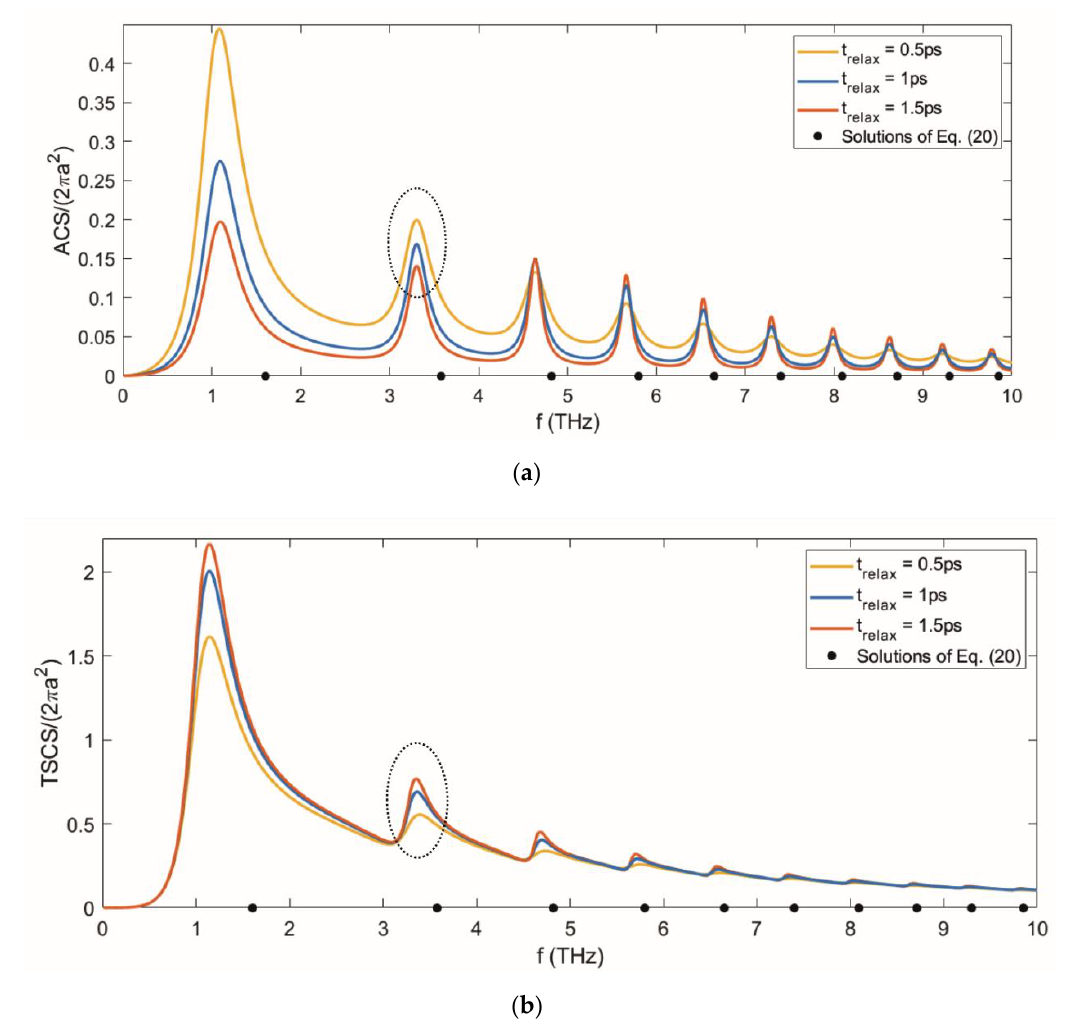
Figure 3. Normalized ACS and TSCS, when a plane wave orthogonally impinges onto the disk, and solutions of Equation (20) of the graphene disk with a = 50 µ m, T = 300 K, t relax = 0.5 ps,1 ps,1.5 ps, µ c = 1 eV, for varying values of the frequency ( f ). ( a ) Normalized ACS; ( b ) Normalized TSCS.